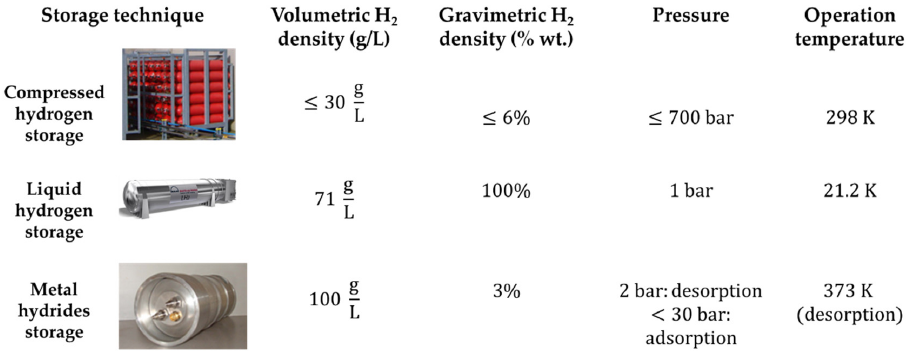
Figure 10. Portfolio of hydrogen storage